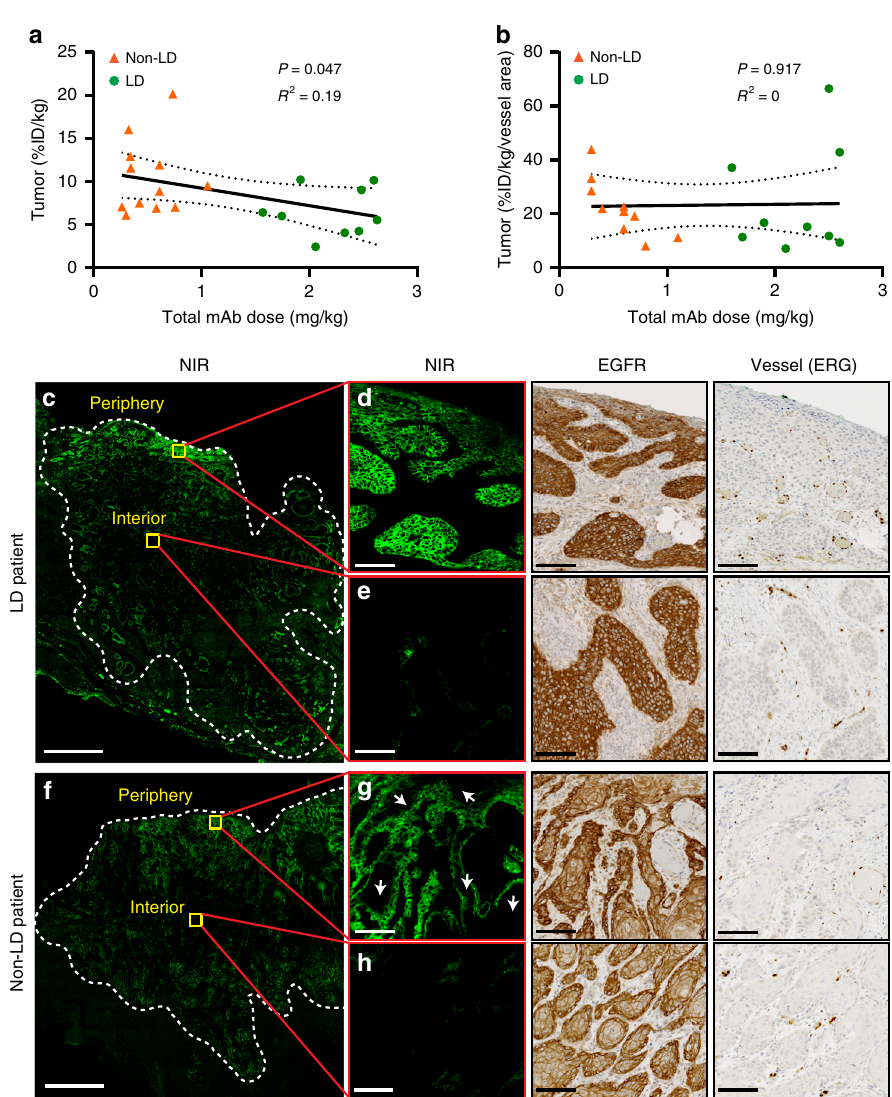
Fig. 6 The impact of loading dose on total antibody uptake. a Tumor uptake (%ID kg − 1 ) showed slightly decreasing trend with increasing total antibody dose. b Tumor uptake (%ID kg − 1 ) normalized by vessel area fraction showed a constant trend with increasing total antibody dose, suggested the variations in vessel area between the two groups may have caused the downward trend in tumor uptake before normalization. c – h Examples from a LD patient and non-LD patient demonstrated partial saturation in the tumor periphery with loading dose. (Scale bar in c and f : 2 mm; scale bar in d , e , g , h : 100 μ m). Linear regression was performed in a , b with the best- fi t line (solid line), the 95% con fi dence bands (dotted line), goodness of fi t ( R 2 ), and p